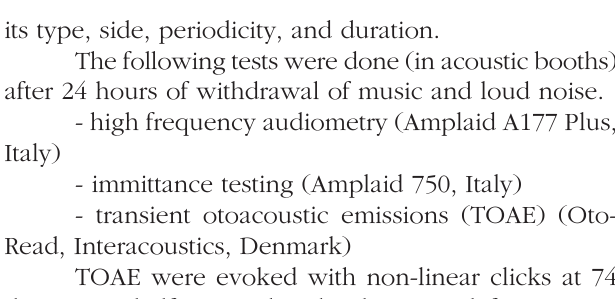
Table 1. Analysis of clinical variables according to use of personal stereo devices.